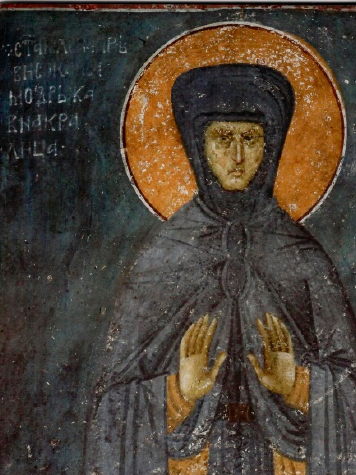
Figure 10. Queen Helen as a nun, 1322, Church of the Annunciation of the Gra č anica Monastery, eastern wall. Photo by Sr đ an Vulovi ć , courtesy of the National Museum of Kraljevo.